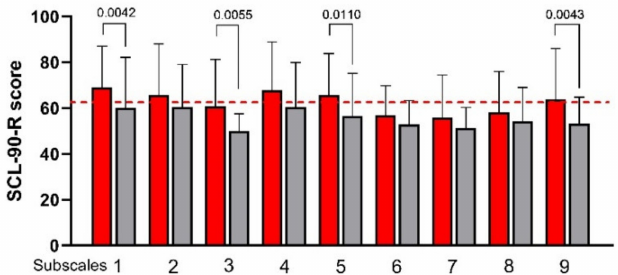
Figure 2. The Symptom Checklist-90-Revised (SCL-90-R) subscale scores before and after low FODMAPs diet. Data are presented as mean ± SD. Statistical analysis: Wilcoxon matched-pairs signed-rank test with a significant difference set at p < 0.05. Subscales: (1) Somatization; (2) Obsessive- Compulsive; (3) Interpersonal Sensitivity; (4) Depression; (5) Anxiety; (6) Hostility; (7) Phobic Anxiety; (8) Paranoid Ideation; (9) Psychoticism. The cutoff value is indicated by the red dashed line.